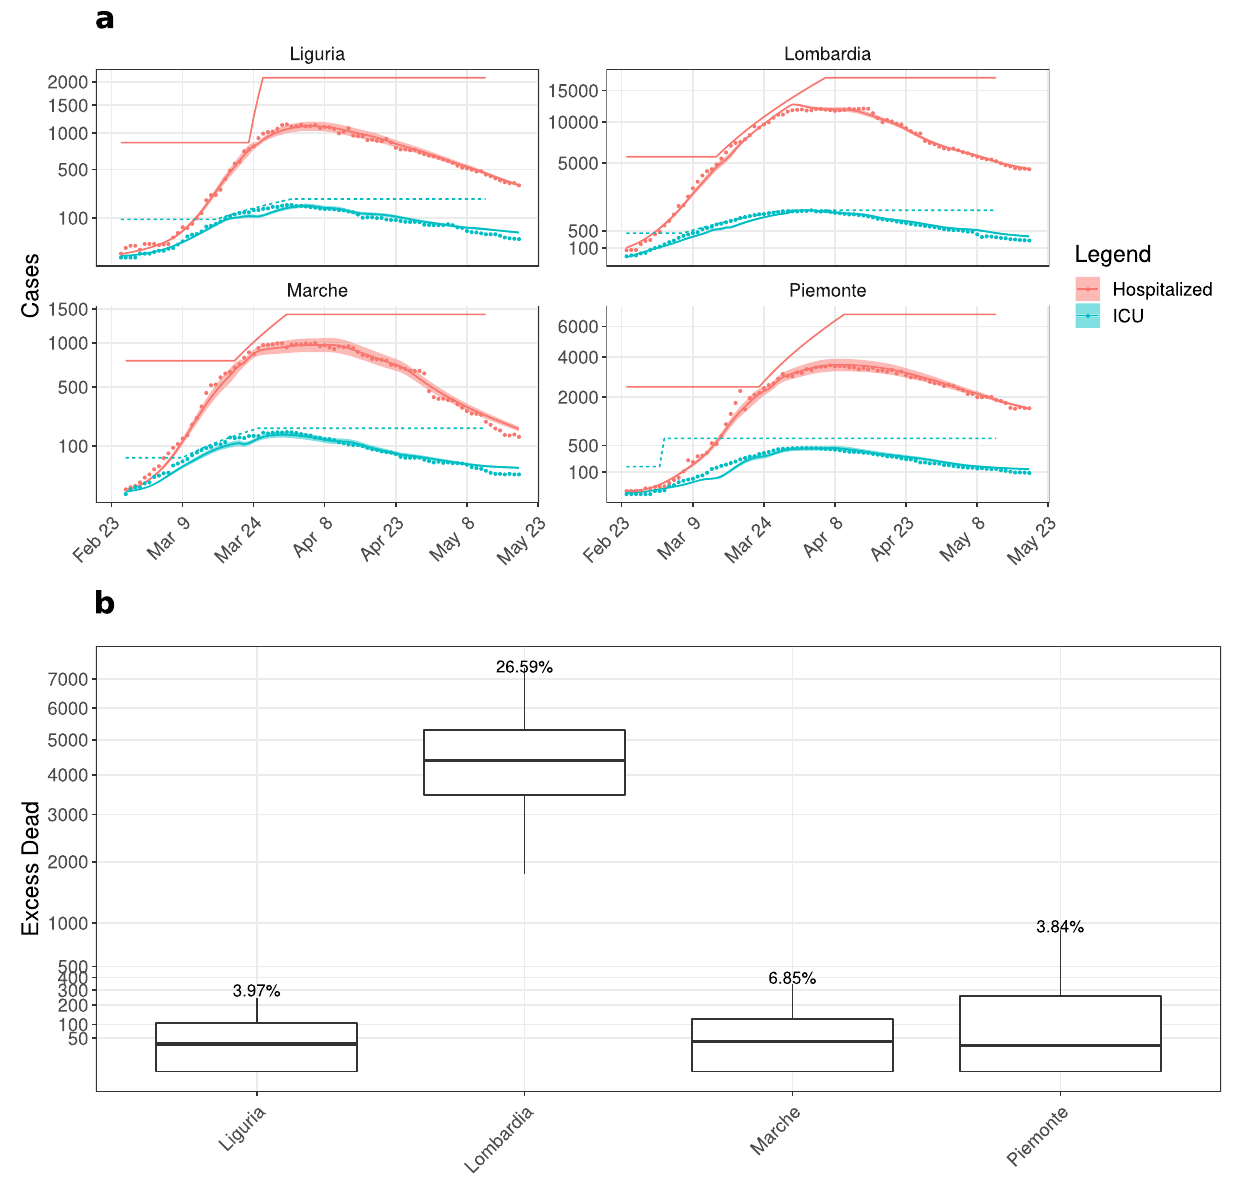
Fig. 6 Life costs of the limited healthcare system. a Sample Capacity Model fi t of hospitalized (red), ICU (iris-blue) data for the most affected regions. Parameters were fi tted as in the Reference Model by considering the fi rst 3 months (February 24 th – May 22 nd , 2020) data. Continuous lines: simulation results; round dots: data; Baseline capacity and linear increase in hospital (red) and Intensive Care Units (ICU) (iris-blue) capacity (Table 3) are represented as lines with the respective color. b Box plot of the difference in death numbers between the results of the Capacity and the MaxCap Model . Statistics performed over 100 perturbed parameter sets (see Methods) and the box plot shows the median, 25- and 75-percentiles as well as the minimum and the maximum values. We analysed the variation in the excess dead numbers depending on different values of α for the most affected region, Lombardia (Supplementary Fig.